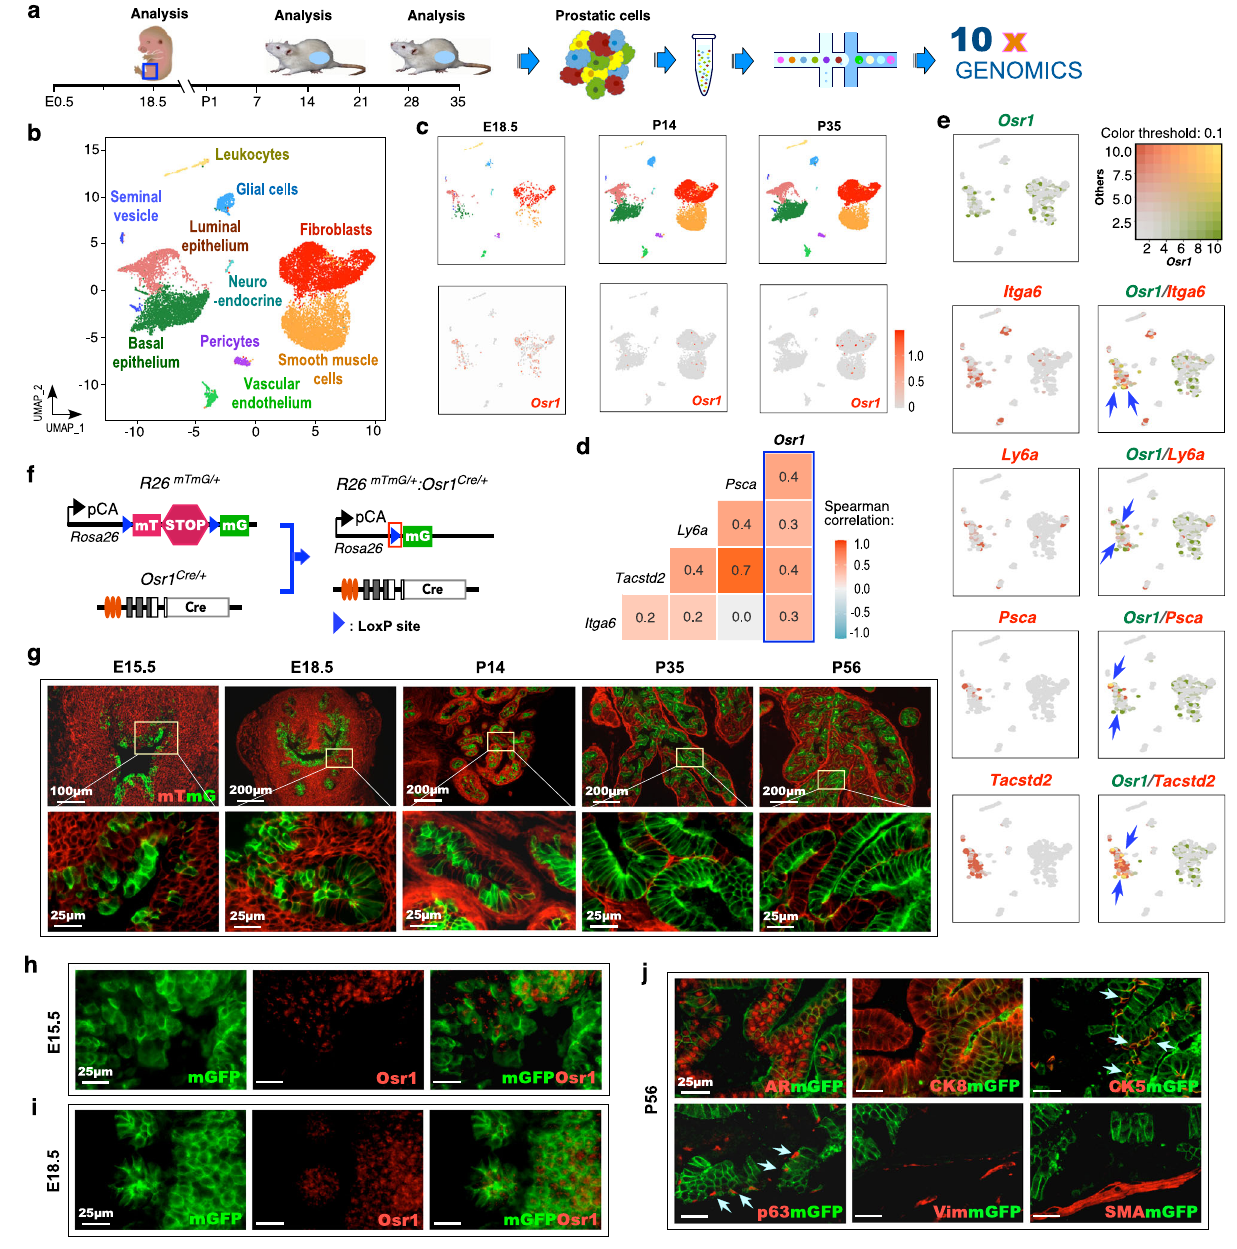
Fig. 1 | Prostatic Osr1 -expressing cells possess progenitor properties in expansion of prostatic epithelia through embryonic and pubescent develop- ment. a Schematic of the single cell RNA-sequencing experiment performed. b Uniform Manifold Approximation and Projection (UMAP) plot showing the cell type cluster identities based on gene expression patterns. c Three individual UMAP plots of single cells at the indicated time points after separation from the original clustering. Gene expression UMAP plots displaying the expression pattern of the Osr1 gene at the indicated time points. Color intensity indicates the scaled expres- sion level in each cell. d Heatmap of pairwise Spearman correlation between the indicated gene expression in epithelial cells from E18.5 male urogenital sinus (UGS). Colors re fl ect the level of correlation (positive correlation in red and negative cor- relation in blue); numbers show the correlation coef fi cient. The blue box highlights the correlation between Osr1 and other progenitor cell markers. e Blended